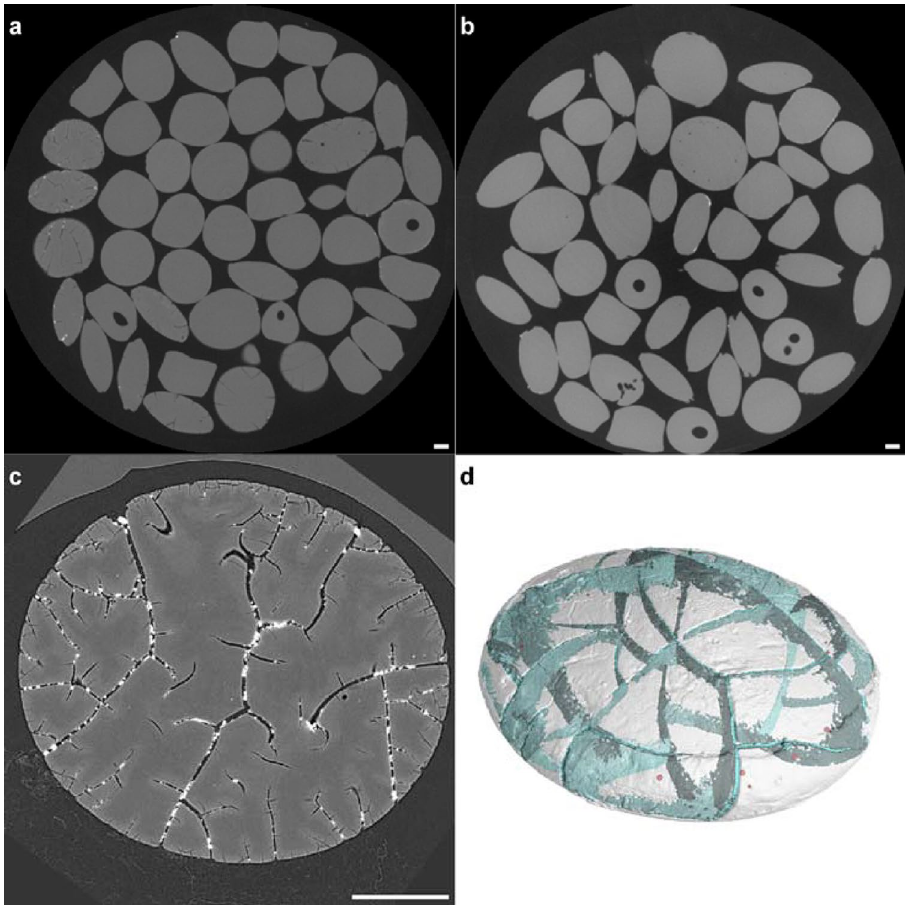
Figure 4. Slices of µCT scanned MP resin pellets from a nearby beach in the Wadi el Gemal national park, Egypt, and the SS Hamada wreck in the Red Sea. Overviews of different MP from ( a ) the beach and ( b ) from SS Hamada wreck revealed several cavities that are most likely a result of production conditions. ( c ) Pellets from the beach often showed white spots that indicate the presence of minerals inside distinctive cracks. ( d ) 3D reconstructions of µCT slices exhibited that cracks (blue) formed a complex network which reached the inner part of beached MP. Further crack propagation will most likely lead to fragmentation of pellets into even smaller MP. Red dots indicate closed pores inside the pellet. Scale bars: 1